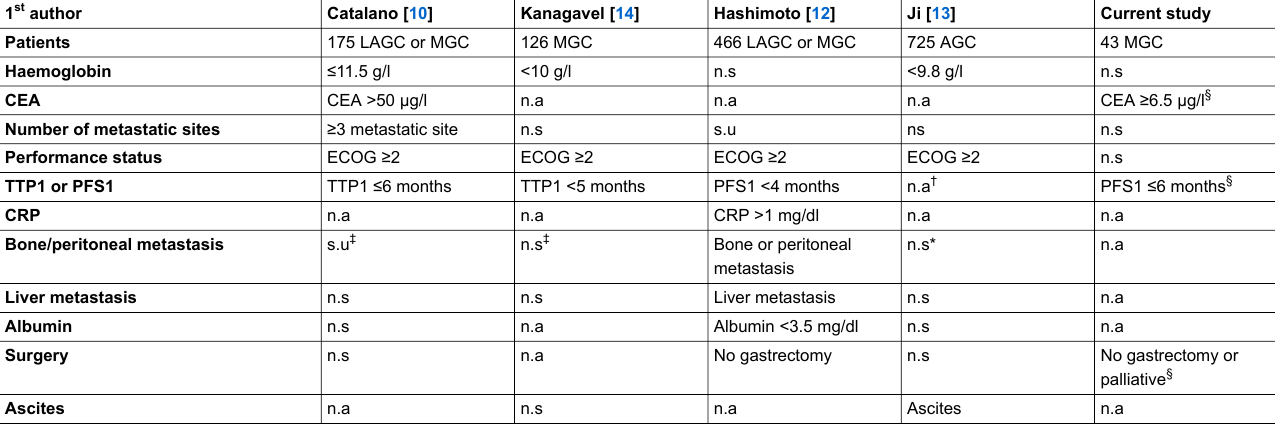
Table 5: Published adverse prognostic clinical factors in patients with advanced gastric cancer treated with second line